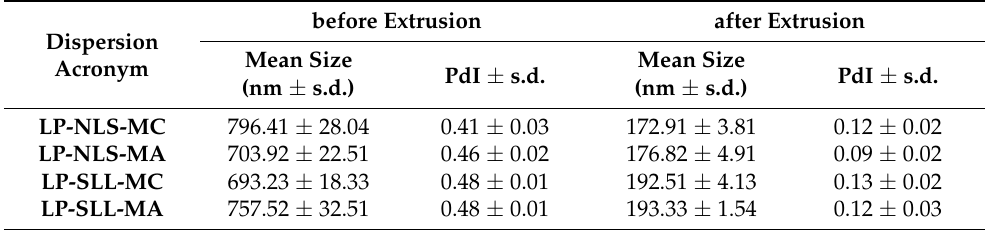
Figure 5. ζ potential values of unloaded or manganese-loaded NLS and SLL liposomes. Table 4. Size of Mn-loaded LP-SLL and LP-NLS measured before and after extrusion.